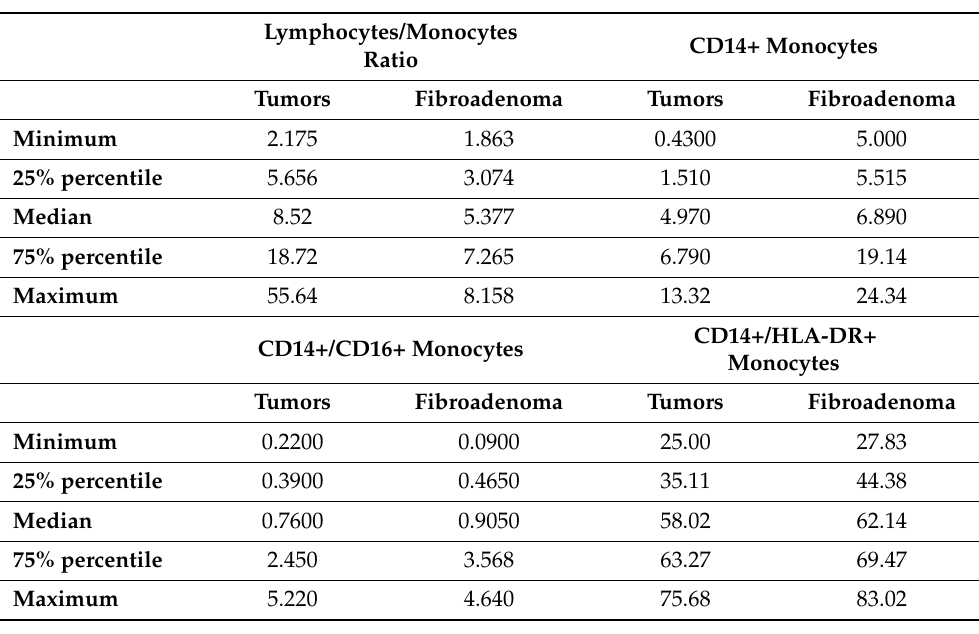
Figure 9. Monocyte subset percentages were plotted according to the specific membrane receptors, in tumor (black dots) and fibroadenoma (white dots) tissue patients. ( A ) Lymphocytes-to-monocytes ratio. ( B ) CD14 pos monocytes. ( C ) CD14 pos /CD16 pos atypical monocytes. ( D ) CD14 pos /HLA-DR pos monocytes. The median and standard deviation are reported. * = p -value < 0.05 and ** = p -value < 0.01; and unpaired t -tests. n.s. = not significant. Table 4. Statistical values of the monocyte subsets. Values are reported as the median percentage of gated